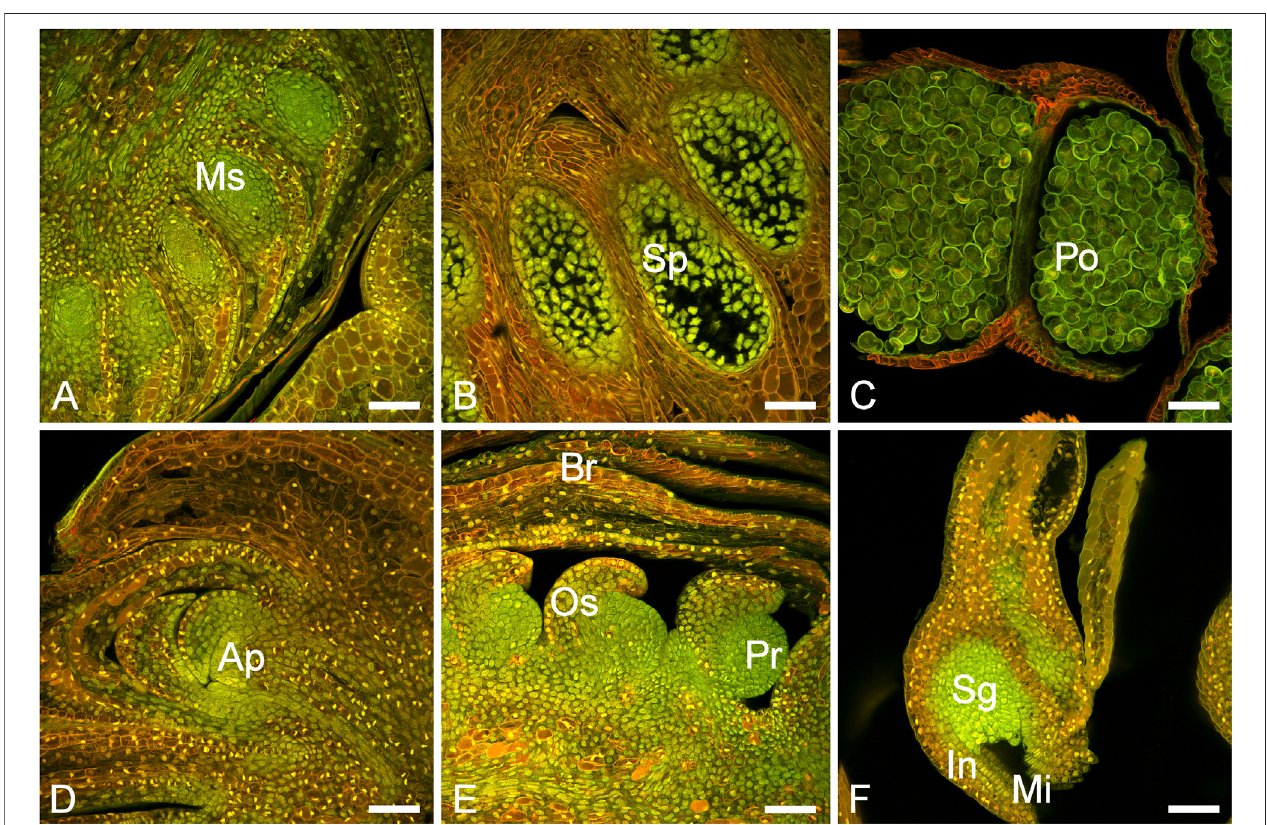
FIGURE1| Maleandfemaleconedevelopmentin P.densi fl ora . (A) Immaturemalebud(MC-1)withdevelopingmicrosporangia(Ms). (B) Immaturemalecone(MC- 2)withsporocytes(Sp). (C) Maturemalecone(MC-3)withpollengrains(Po). (D) Vegetativebud(apex)showingtheapicalmeristem(Ap). (E) Developingfemalebud(FC- 1/FC-2) showing ovuliferous scales (Os), primordium (Pr) and bracts (B) . (F) A mature ovule (FC-3) showing the sporangium (Sg), integuments (In) and micropyle (Mi). Scale bars = 100